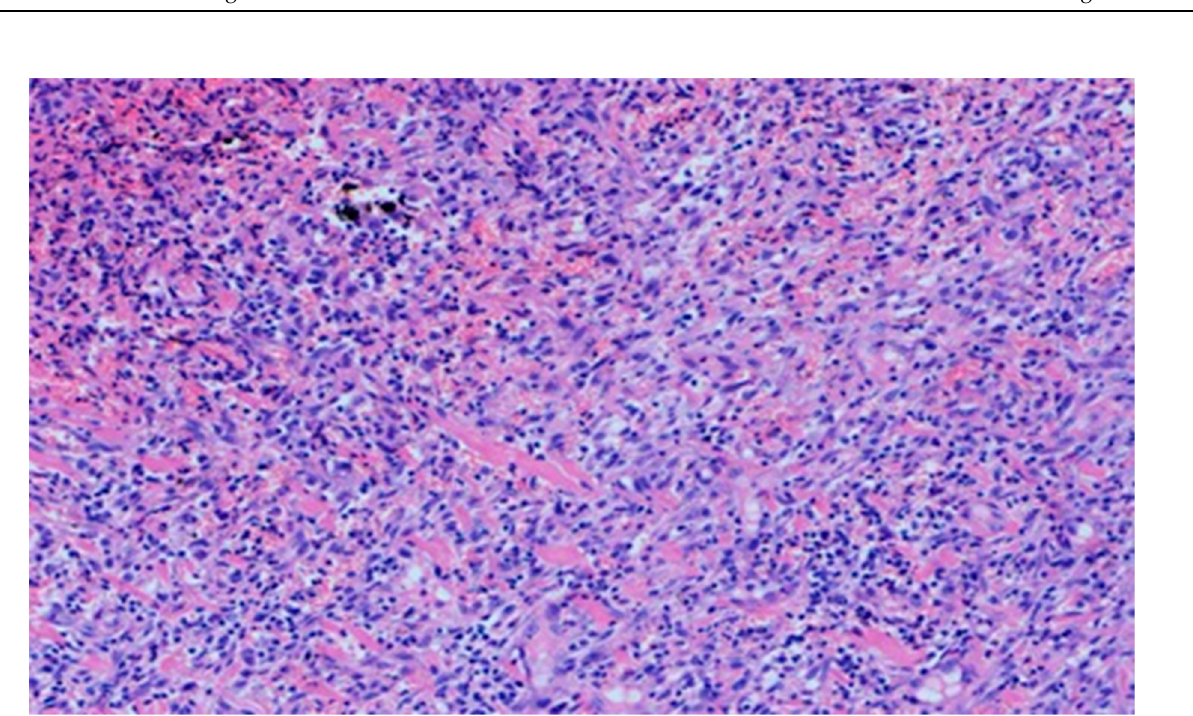
Figure 20. Mixed lymphocytic-granulocytic inflammatory infiltration, medium density, in the dermis (100×, H-E) in the wound treated with sulfathiazole on day 20.